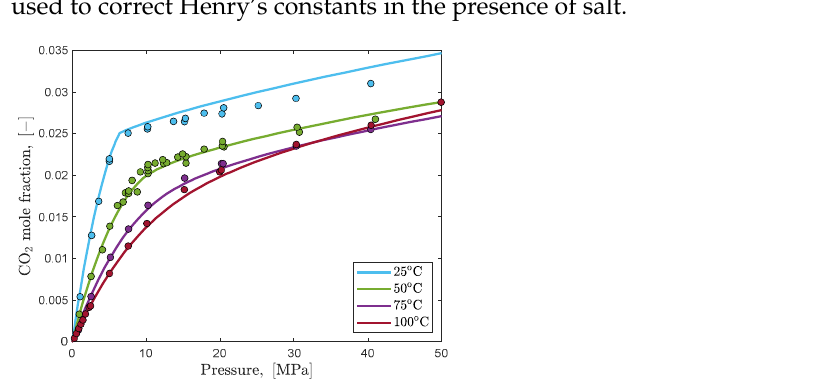
Figure 5. Solubility of CO 2 in pure water as a function of pressure and temperature. The discrete points represent experimental data from [52], and the continuous lines are calculated by the simulator.